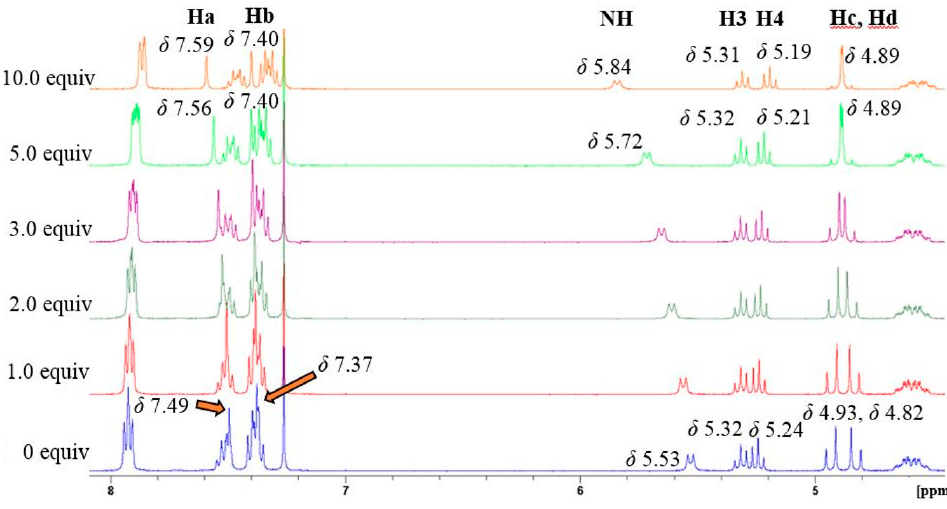
Figure 5. The 1 H NMR spectra of compound 24 with different amounts of TBACl. The binding properties of the macrocycles LM28 , DM35 with Cu 2+ were also studied using several macrolactones and 1 H NMR spectroscopy at variable temperatures. The 1 H NMR spectra of DM35 and its complex with CuSO 4 ∙ 5H 2 O are shown in Figures 6 and S23–S25. In the complex, the two sharp triazole singlets at 7.70 and 7.69 ppm disappeared or became broadened and shifted downfield to around 7.81 ppm. The triazole signals were very broadened due to the paramagnetic properties of Cu (II) binding to triazole [40]. Typically, protons within 0.9 nm of the Cu (II) were not observed due to fast paramagnetic relaxation, and the protons in the outer shell between 0.9–1.7 nm from the copper showed chemical shift changes and broad resonances [41]. The signals far away from Cu (II) were not affected as much (Figure S23). This showed that the copper ion is in close vicinity to the triazoles.